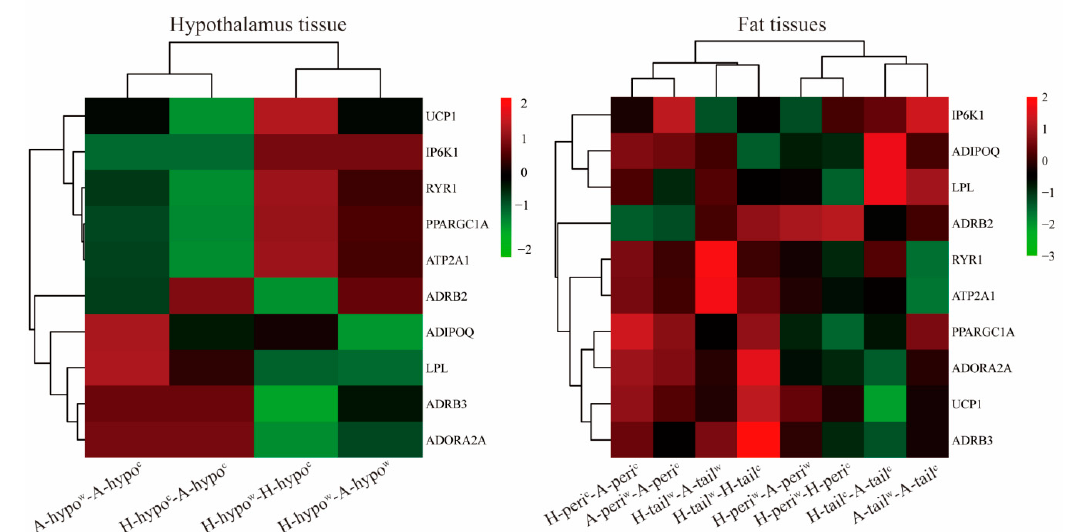
Figure 7. The heat map of candidate gene clustering in the hypothalamus and fat tissues. H-hypo w - A-hypo w : hypothalamus tissue of the 20 °C Altay lambs compared to the 20 °C Hu lambs. H-hypo c - A-hypo c : hypothalamus tissue of the − 5 °C Altay lambs compared to the − 5 °C Hu lambs. H-hypo w -H-hypo c : hypothalamus tissue of the − 5 °C Hu lambs compared to the 20 °C Hu lambs. A-hypo w -A-hypo c : hypothalamus tissue of the − 5 °C Altay lambs compared to the 20 °C Hu lambs. H-tail w -A-tail w : tail-fat tissue of the 20 °C Altay lambs compared to the 20 °C Hu lambs. H-tail c -A-tail c : tail-fat tissue of the − 5 °C Altay lambs compared to the − 5 °C Hu lambs. H-tail w -H-tail c : tail-fat tissue of the − 5 °C Hu lambs compared to the 20 °C Hu lambs. A-tail w -A-tail c : tail-fat tissue of the − 5 °C Altay lambs compared to the 20 °C Hu lambs. H-peri w -H-peri c : perirenal fat tissue of the − 5 °C Hu lambs compared to the 20 °C Hu lambs. H-peri w -A-peri w : perirenal fat tissue of the 20 °C Altay lambs compared to the 20 °C Hu lambs. H-peri c -A-peri w : perirenal fat tissue of the − 5 °C Altay lambs compared to the − 5 °C Hu lambs. A-peri w -A-peri c : perirenal fat tissue of the − 5 °C Altay lambs compared to the 20 °C Hu lambs. Candidate genes were clustered with log2 changes (log2 FC >1, p < 0.05) in all compared groups included in this heatmap. Hierarchical clustering of samples was based on Pearson’s correlation coefficient, and scales were performed in rows. FC, fold change.